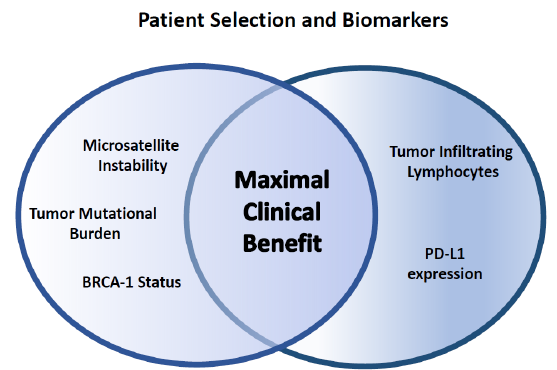
Figure 1. Biomarker development for optimization of immunotherapy use in patients.